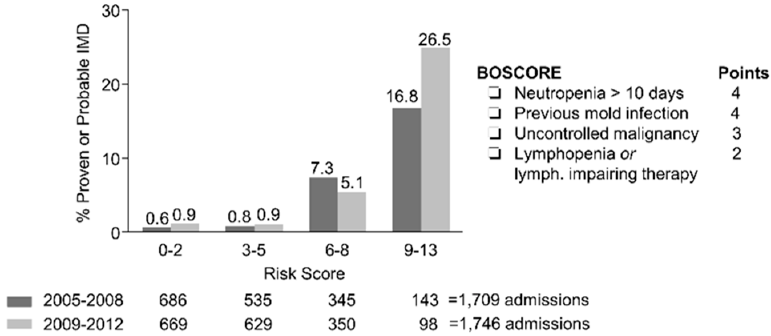
Figure 2. BOSCORE distribution versus observed 90-day cumulative incidence of IMD in the retrospective (2005–2008) development and prospective (2009–2012) validation cohorts.